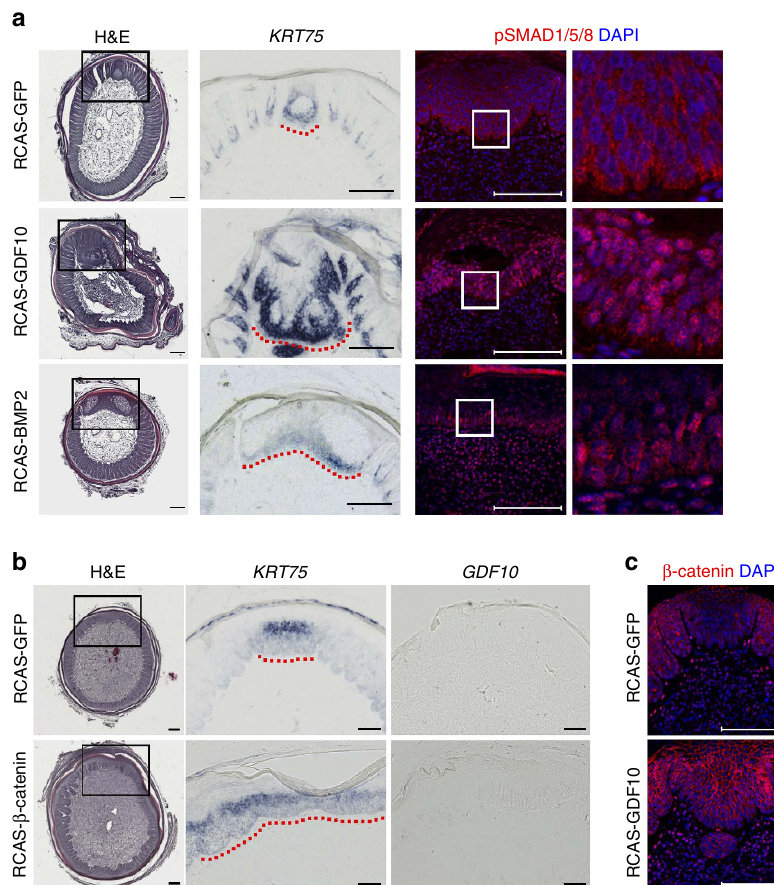
Figure 3 | GDF10 is a crucial modulator of rachis topology. ( a ) Compared with the RCAS-GFP (control) infected neonatal primary remiges, GDF10 and BMP2 mis-expressing feathers developed enlarged rachises as shown by Hematoxylin & Eosin (H&E) staining and KRT75 in situ hybridization. Nuclear pSMAD1/5/8 positive cells also increased in the rachis region. Dotted red lines highlight the rachis. Scale bar, 100 m m. ( b ) RCAS- b -Catenin infected neonatal remiges developed expanded rachis without notable upregulation of GDF10 expression. Dotted red lines highlight the rachis. ( c ) RCAS-GDF10 infection increased nuclear b -Catenin positive cells in the pulp adjacent to the rachis. Scale bar, 100 m